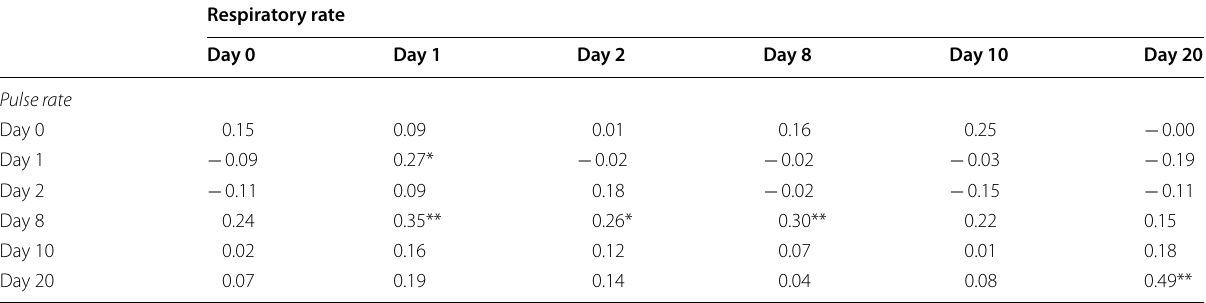
Values with asterisk are significantly * P < 0.05; ** P <